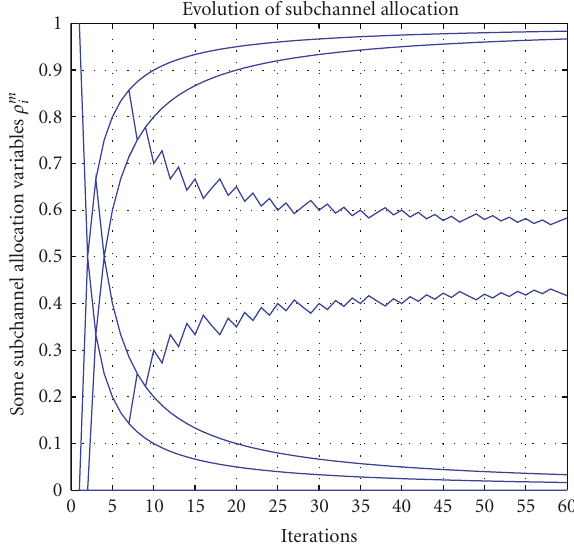
Figure 6: Evolution of some subchannel allocation variables ρ m